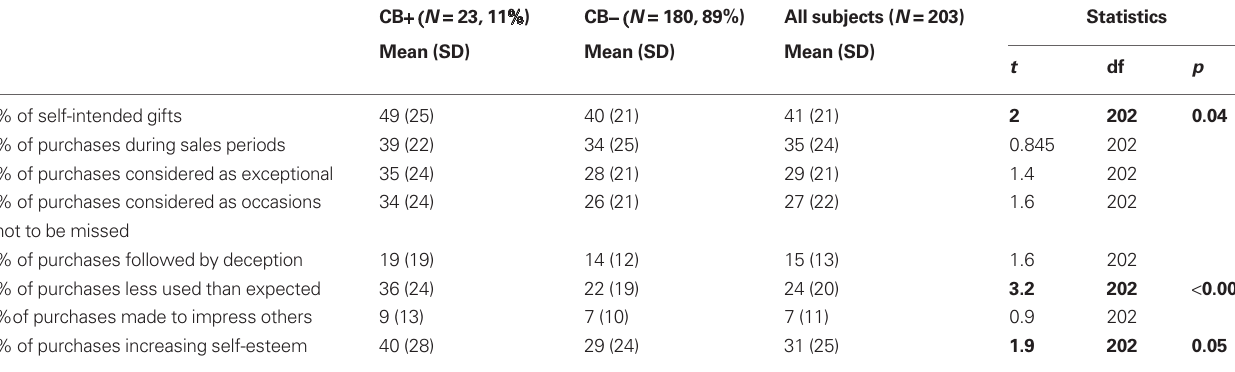
Table 2 | Comparison of subjects presenting with (CB + ) or without (CB − ) compulsive